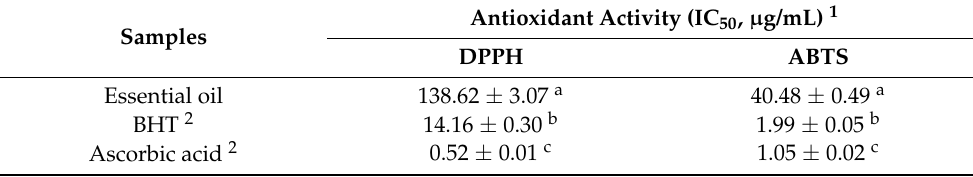
Table 2. Antioxidant activity of A. galanga flower essential oil.